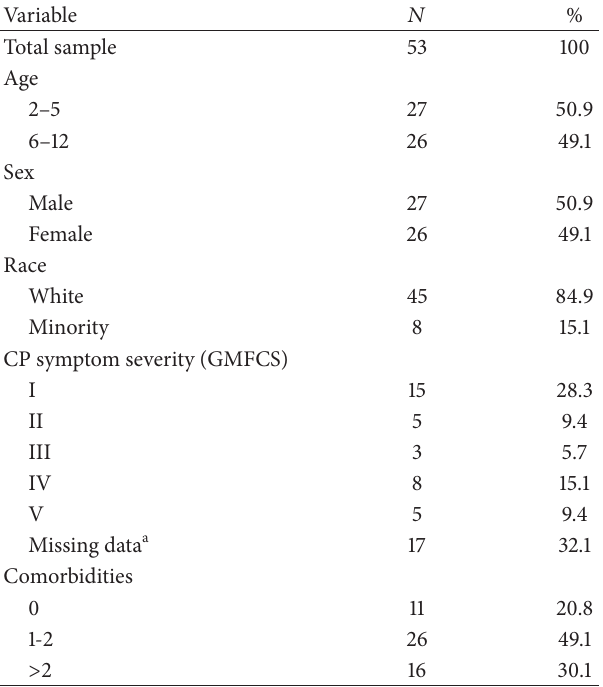
Table 1: Demographic characteristics and health status of a sample of children with cerebral